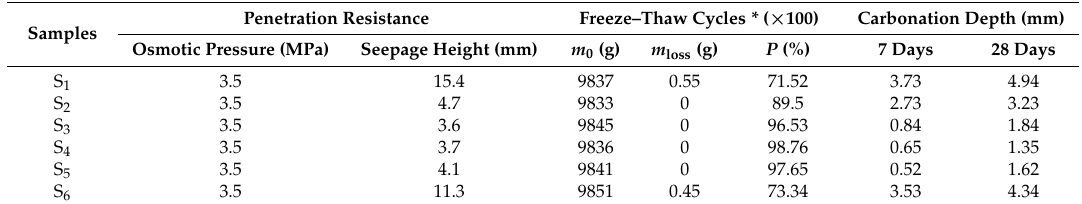
Table 6. Durability parameters of GO/cement composites at 28